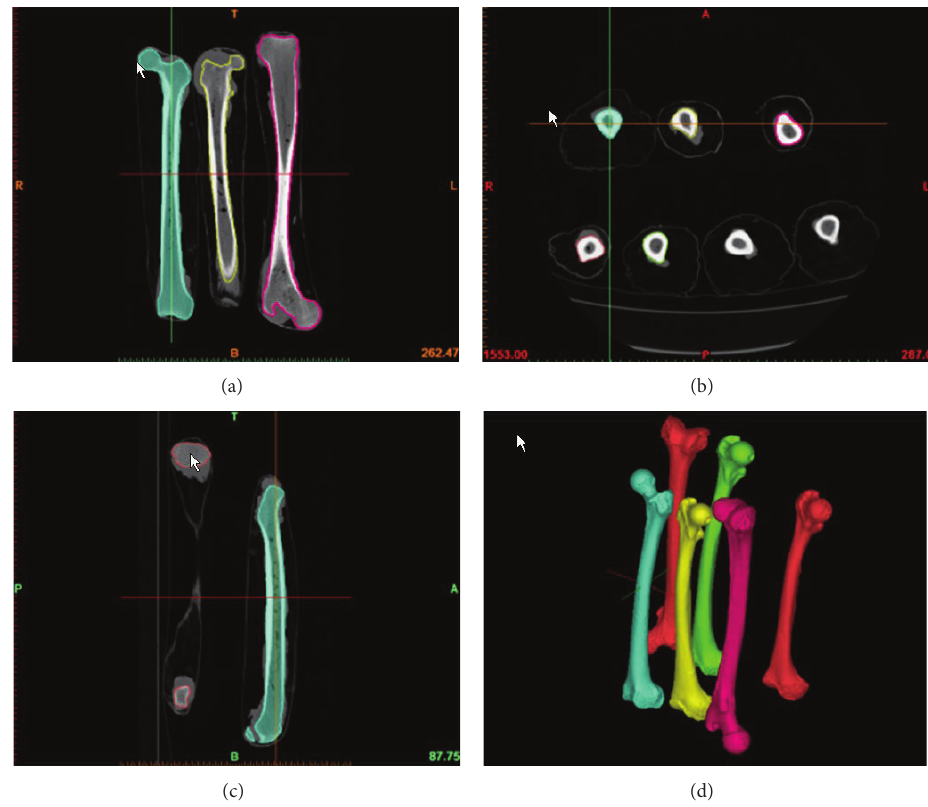
Figure 1: (a)–(c) Image segmentation. (d) Bone allograft was 3D